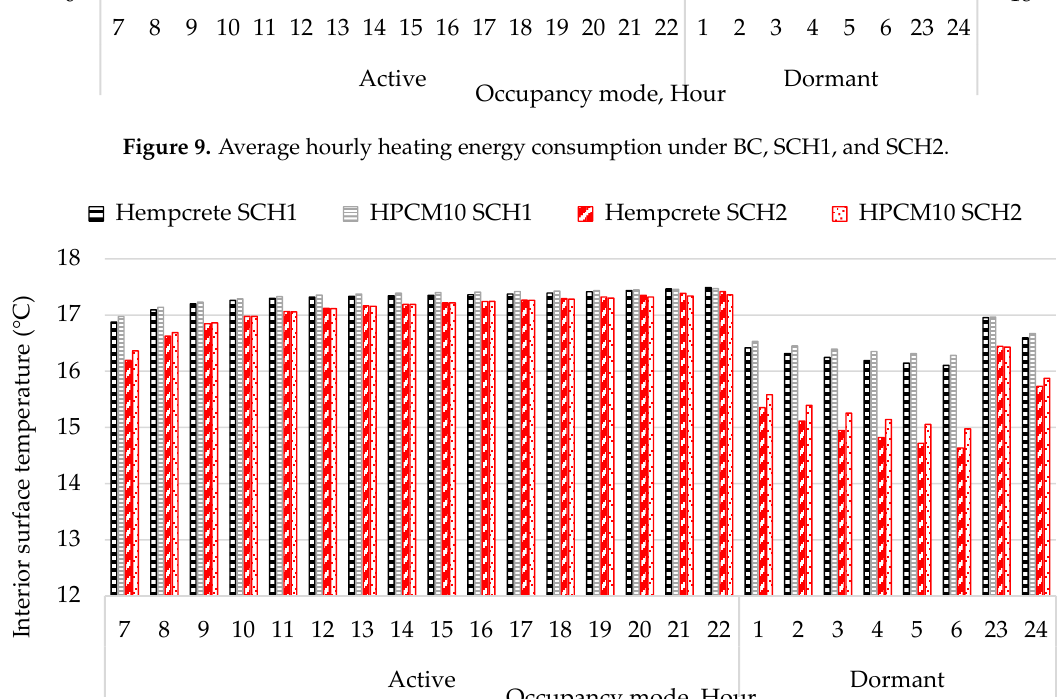
Figure 10. Average hourly interior surface temperatures under BC, SCH1, and SCH2. A possible explanation for better performance of the HPCM10 wall than the hempcrete case during the night may lie in significantly lower thermal diffusivity (i.e., the lower rate at which heat disperses throughout the material) of the HPCM10 assembly than the hempcrete wall. In this respect, due to around 8.7% lower thermal conductivity and 17–73% higher specific heat capacity of HPCM than hempcrete, HPCM has 26–76% lower thermal diffusivity than hempcrete (see Table 1). Consequently, the HPCM10 wall had a lower heat transfer from the inside (hot) to the outside (cold) than hempcrete assembly, thus maintaining higher indoor surface temperatures and reducing the heating energy consumption during the night. However, the comparison of the HPCM10, hempcrete, and HPCM10 theoretical wall with the same overall heat transfer coefficient as hempcrete wall hourly energy consumption under SCH2 from January 12th to 15th, presented in Figure 11a, indicates another cause for the differences in their performance. Thus, on the one hand, the HPCM10